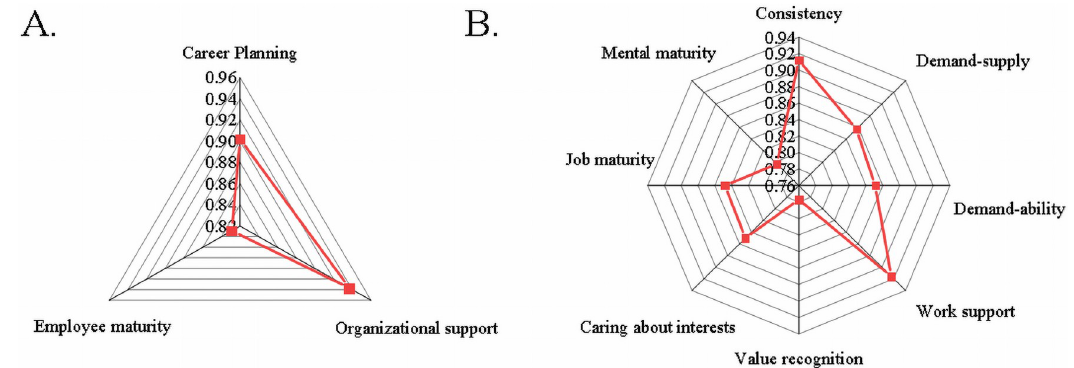
Fig 12. Performance of different models in different data sets. Note: Fig 12-A shows the reliability test results of the scales of different dimensions, and Fig 12-B indicates the reliability test results of the actual indicators.